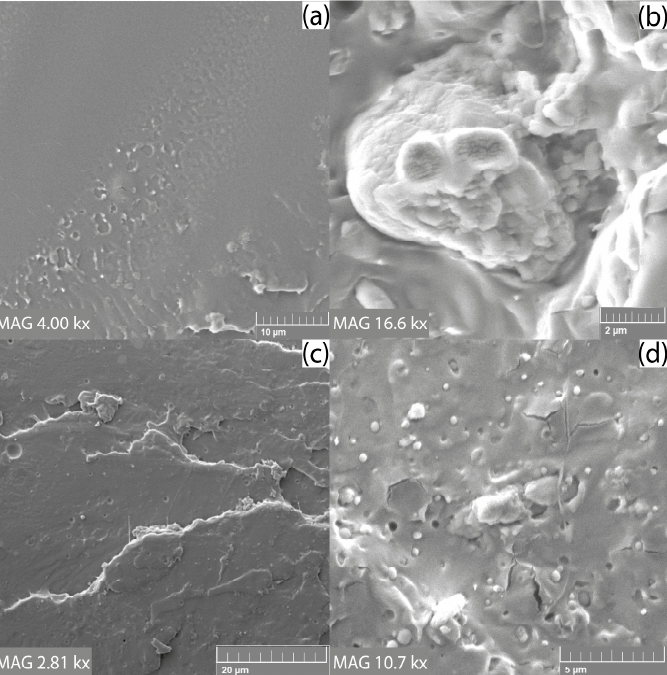
Figure 3. SEM analysis of fractured surfaces: ( a ) PLLA/ATBC, ( b ) PLLA/ATBC/SCG, ( c ) PLLA/PLLA-g-IA/ATBC, and ( d ) PLLA/PLLA-g-IA/ATBC/SCG.